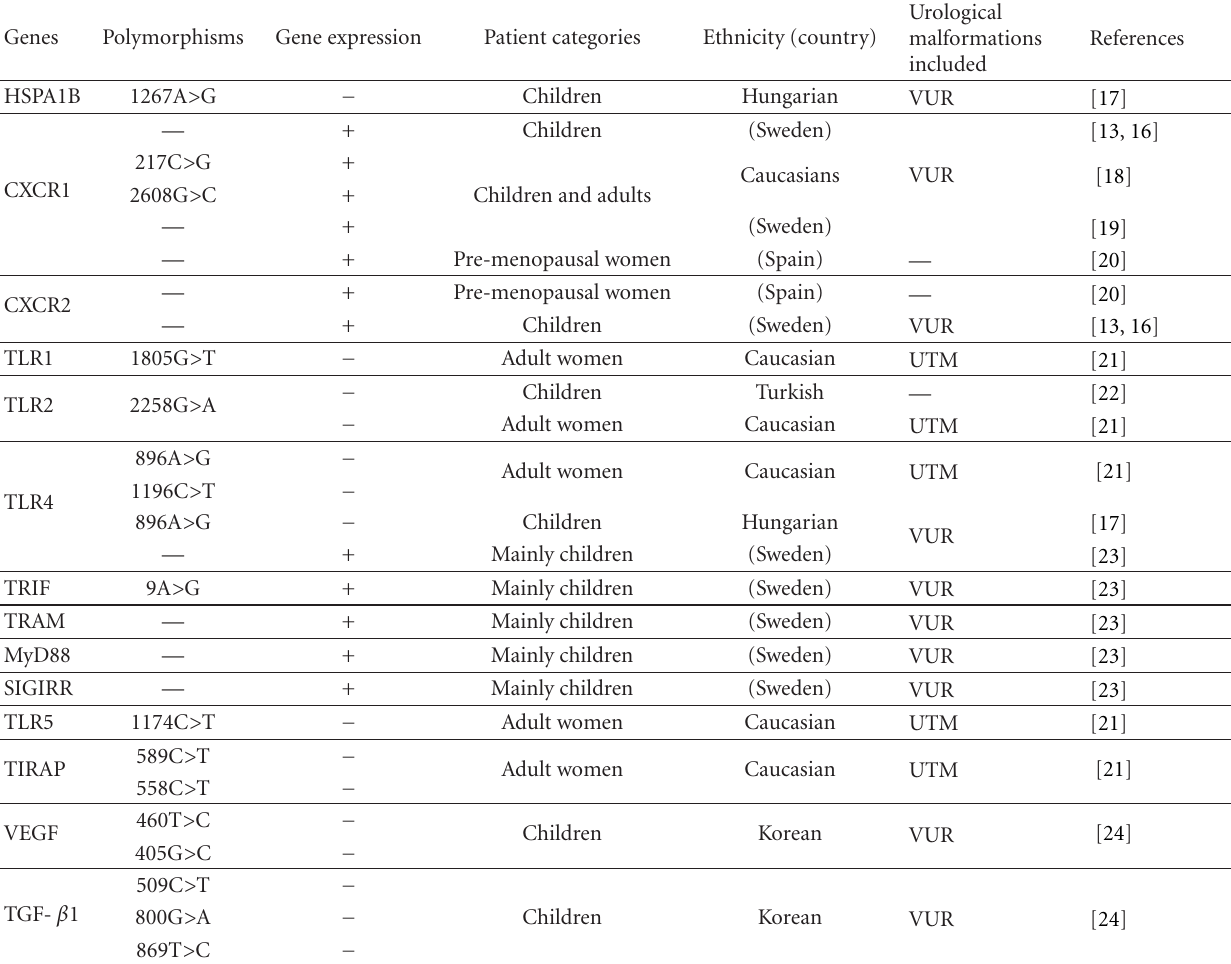
Table 1: Summary of the characteristics of the included studies investigating the polymorphisms and/or mRNA or protein expression assessment in patients with recurrent urinary tract infections (CXCR: IL-8 receptor; HSPA1B: Heat shock protein 72; TGF: Transforming growth factor; TIRAP: TIR domain-containing adapter protein; TLR: Toll-like receptor; UTI: urinary tract infection; UTM: urinary tract malformation; VEGF: Vascular endothelial growth factor; VUR: vesicoureteral